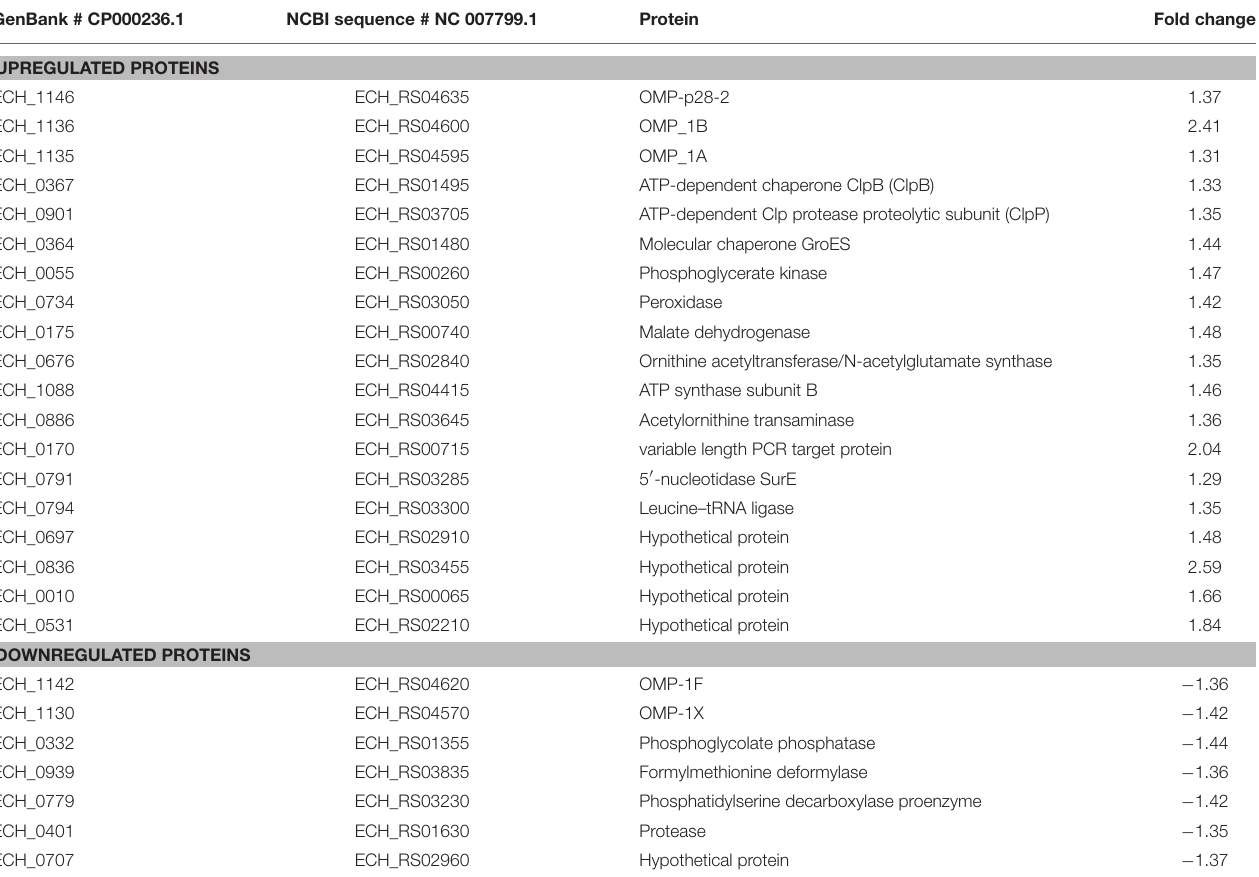
TABLE 1 | Proteins differentially expressed in mutant ECH_0379. GenBank #